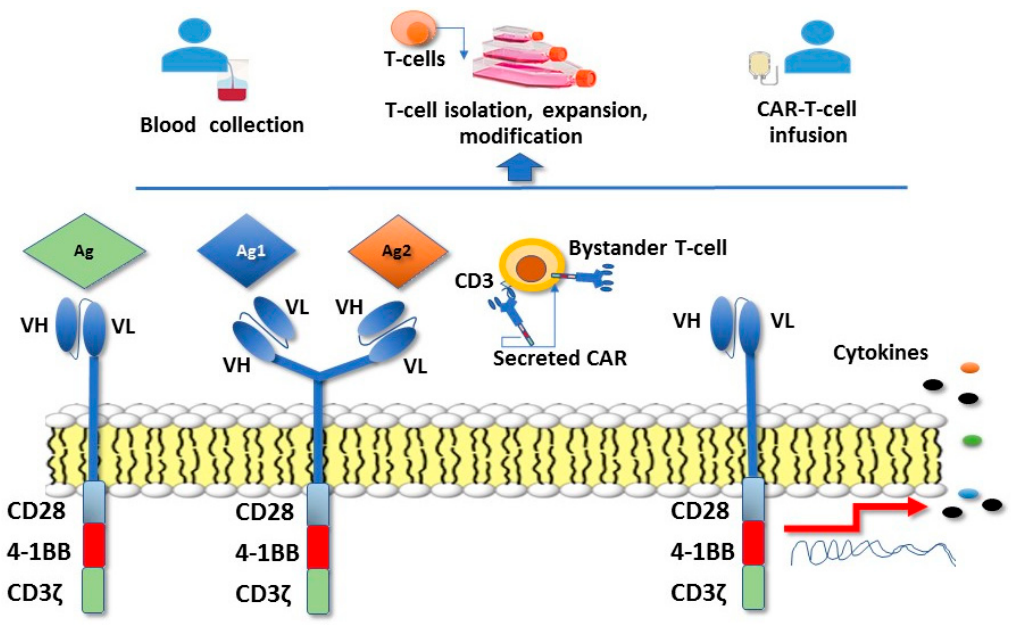
Figure 1. Chimeric antigen receptor (CAR)-T cell therapy T cells are isolated from blood of the patient or a donor, activated, and genetically engineered to express the CAR construct. Engineered CAR-T cells are then reinfused into the patient. The extracellular portion of CAR-T cells is a ligand-binding domain composed of a B cell receptor-derived single-chain variable fragment (VH-VL), whereas the T-cell receptor molecule signalling domain is composed of CD3 molecules and a ζ -chain (zeta chain) and one or more intracellular costimulatory domains required for T-cell stimulation (i.e., CD28 and 4-1BB or CD137). CAR-T cells can also be engineered to recognize two different antigens (dual specificity CAR-T cells). In addition to classical CAR-T cells, new CAR T-like constructs are also able to secrete soluble forms of the CAR receptor. The secreted CAR construct was demonstrated to be able not only to directly kill HER2+ GC, but also to transfer this ability to bystander T cells. More recent approaches have been based on the use of CAR-T cells genetically modified to express CARs along with a gene cassette driving the expression of cytokines (red arrow) that enhance T-cell activity.